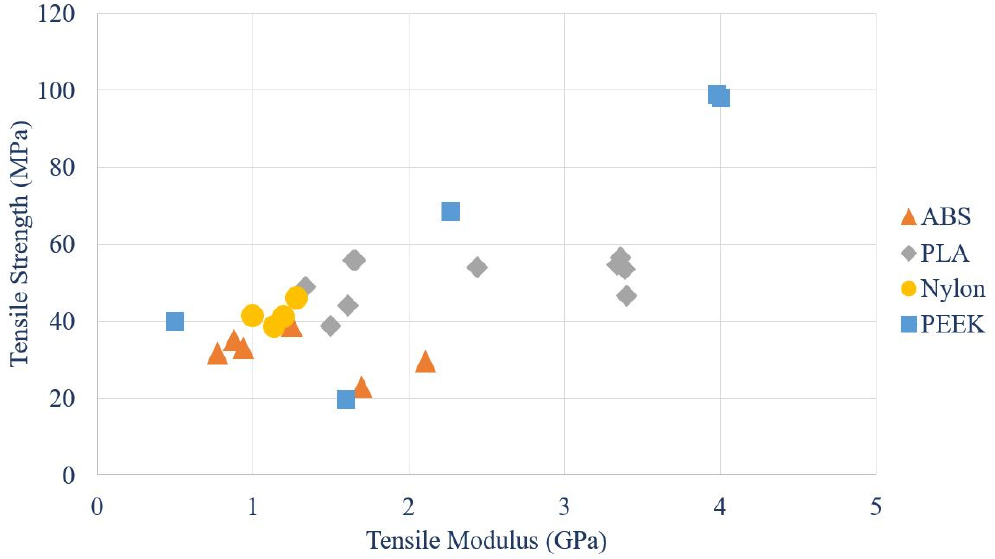
Figure 6. Tensile strength vs. modulus outspread of ABS, PLA, Nylon and PEEK specimens printed via FDM. Data obtained from [44,46,49–51,56,60,64,66–77].